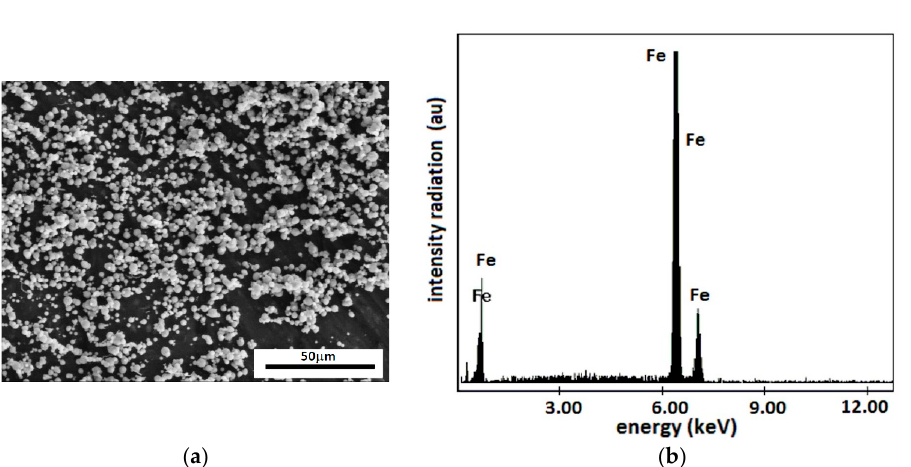
Figure 1. ( a ) SEM morphology of CI microparticles; ( b ) EDX spectra for the elemental analysis of CI microparticles.